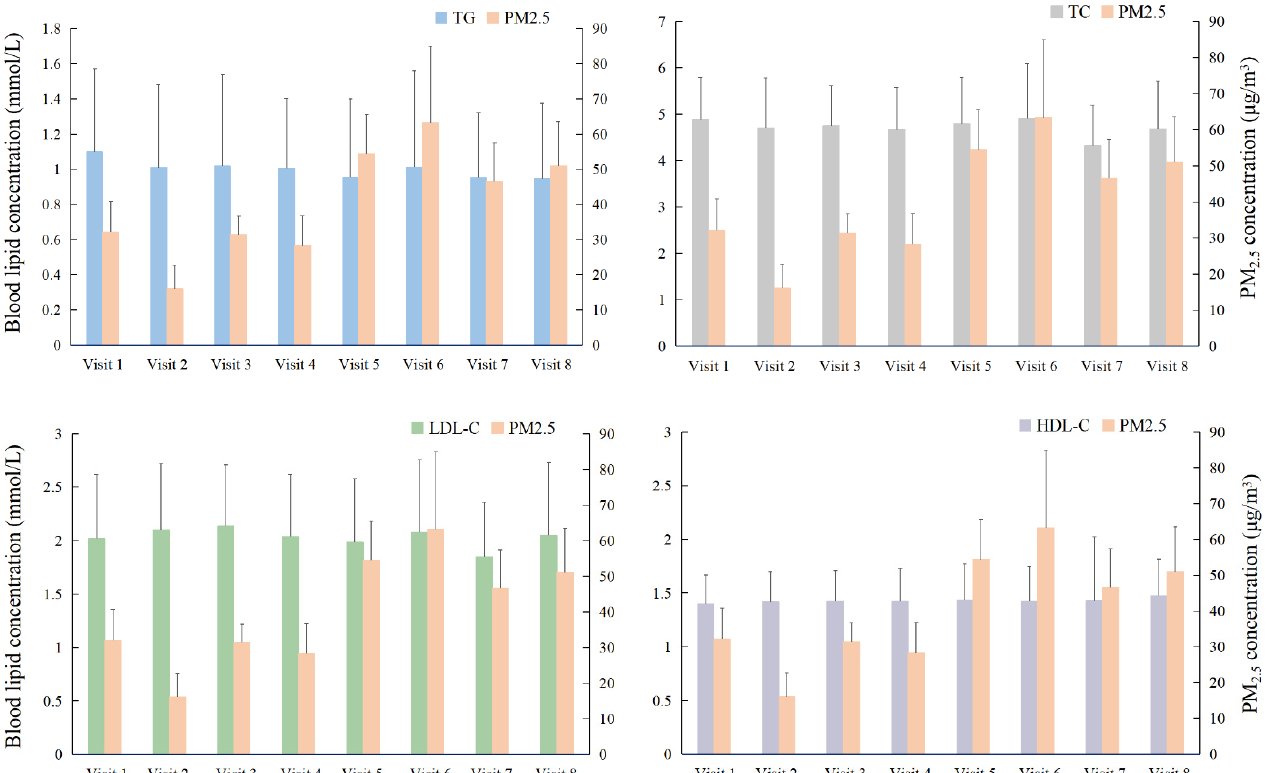
Figure 1. The average TG levels and the 72-h mean concentrations of PM 2.5 with the corresponding standard deviation in the whole study period. The small “tentacles” at the top of the straight bars indicate the corresponding standard deviation. Abbreviations: PM 2.5 , particulate matter with aerodynamic diameter < 2.5 μ m.